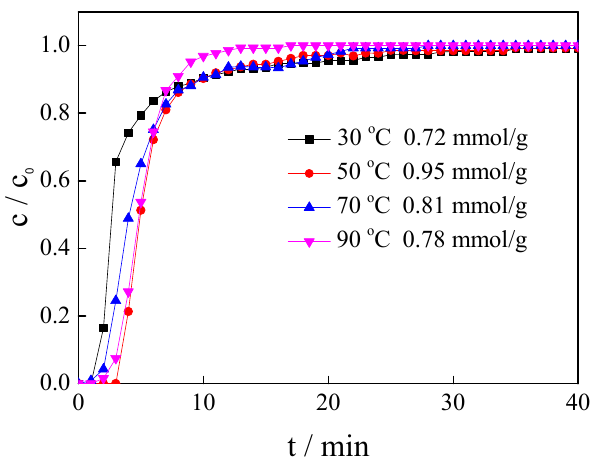
Figure 6. Adsorption curves and CO 2 capacity of magnesite modified by [APMIM]Br at different temperatures (3 g, 30% loading amount, 100 mL/min flow rate and 0 MPa).